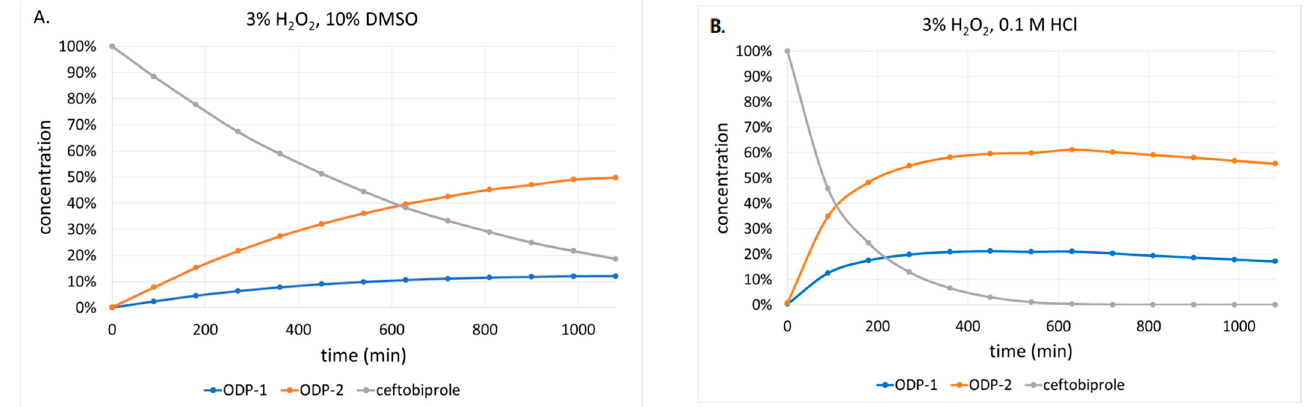
Figure 8. Time dependence of ceftobiprole decomposition in 3% H2O2 in: ( A ) 10% DMSO; ( B ) 0.1 M HCl.